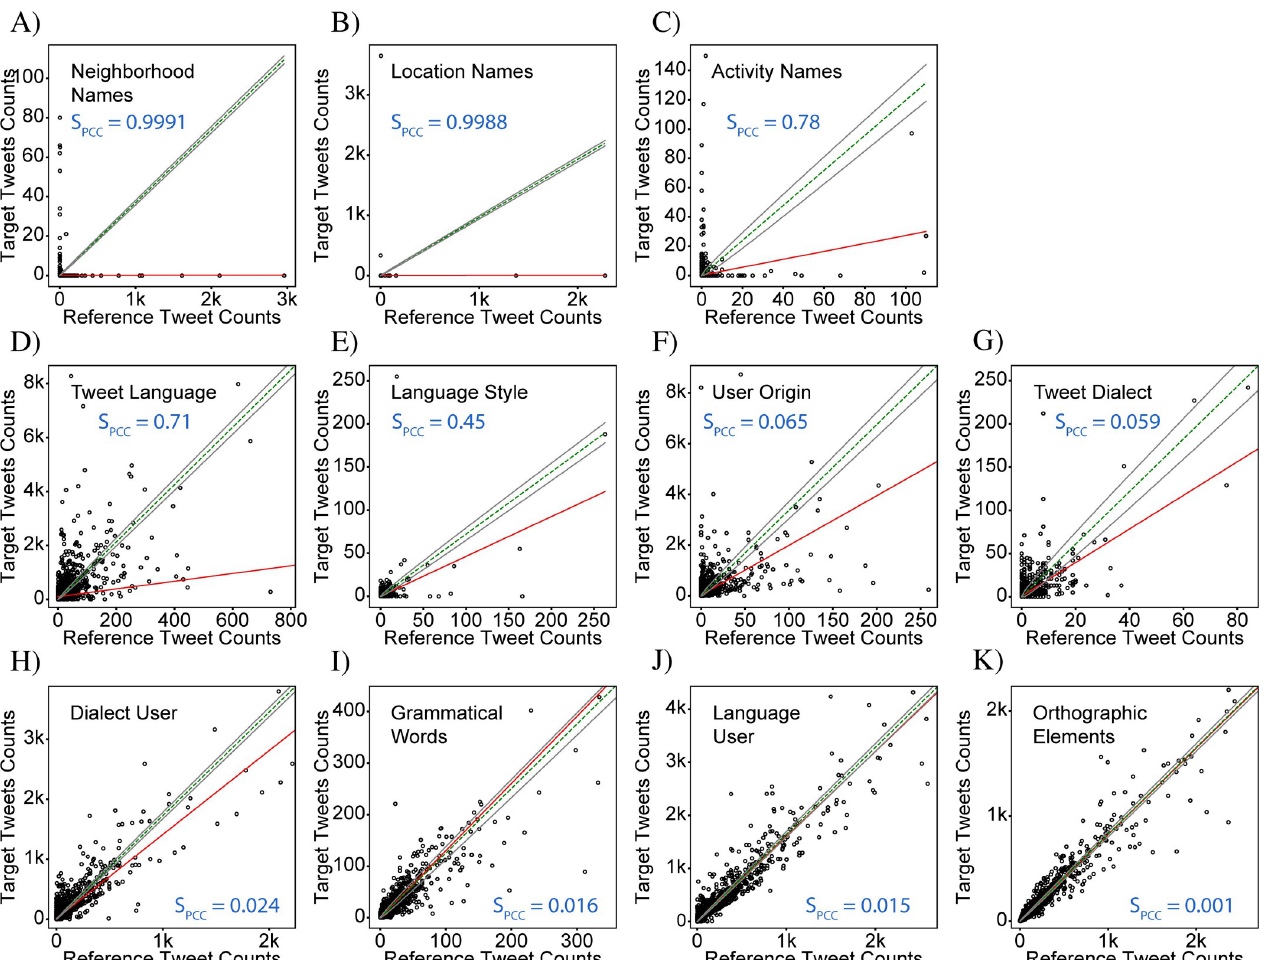
Fig 13. Frequency-comparison plots for the eleven categories of linguistic features. Plots are arranged in order of descending signal strength (S PCC ) from left to right and from up to down. The green-dotted line represents the exact-correlation line, the two grey lines on either side of it indicate the expected range of random statistical variation, and the red line is the linear best fit. For this analysis, the ranges of the x and y axes have been adjusted in order to zoom into the dense part of the plot, allowing for better interpretation of the distribution of points. The sequence of plots shows a pattern of transition from anti-correlation at high signal strength to correlation at low signal strength. Three categories of plot are evident. In the first row, the points have a binary distribution, indicating that tweeters in each location wrote exclusively target or exclusively reference tweets, but not both. This type of distribution shows that the geosocial context had a very strong impact on the tweeting behavior. In the second row, the points demonstrate a large dispersion around the exact-correlation line, indicating that at each location there was a mixture of tweet variants, with the degree of mixing varying somewhat continuously from 0–100% of either variant. This type of distribution shows that geosocial context had a moderately strong influence on tweeting behavior. In the third row, the points are mostly clustered around the exact-correlation line, indicating small deviations from equal representation of the two variants. This distribution shows geosocial context had a small impact on tweeting behavior. This analysis shows that the shape of the frequency-comparison plot provides important information that elucidates the nature of the geosocial context and the resultant geosocial driver. Fig 14 shows the corresponding set of normalized angle histograms arranged in the same order. Once again there is a clear transition from completely flat distributions of angles to strongly-peaked ones as the Pearson coefficients go from zero to one. The three categories of data observed in the frequency-comparison plots are also apparent here. The first row shows angular histograms that are perfectly flat, the second row shows rather even histograms with amplitude over a wide range of angles, while the third row shows histograms with a clear peak around the exact-correlation point (45 degrees). The good correspondence between the shape of the angle histograms, the features of the frequency-comparison plots and the values of the